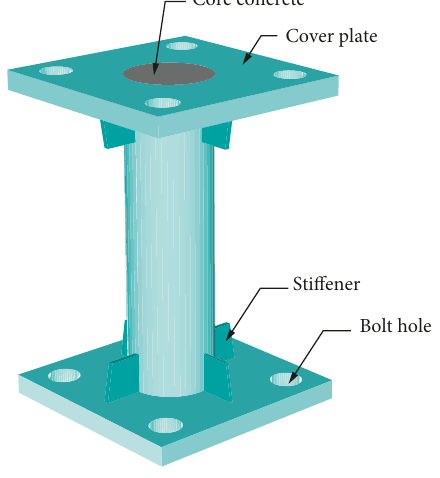
Figure 1: Details of the specimen. Table 2: Properties of